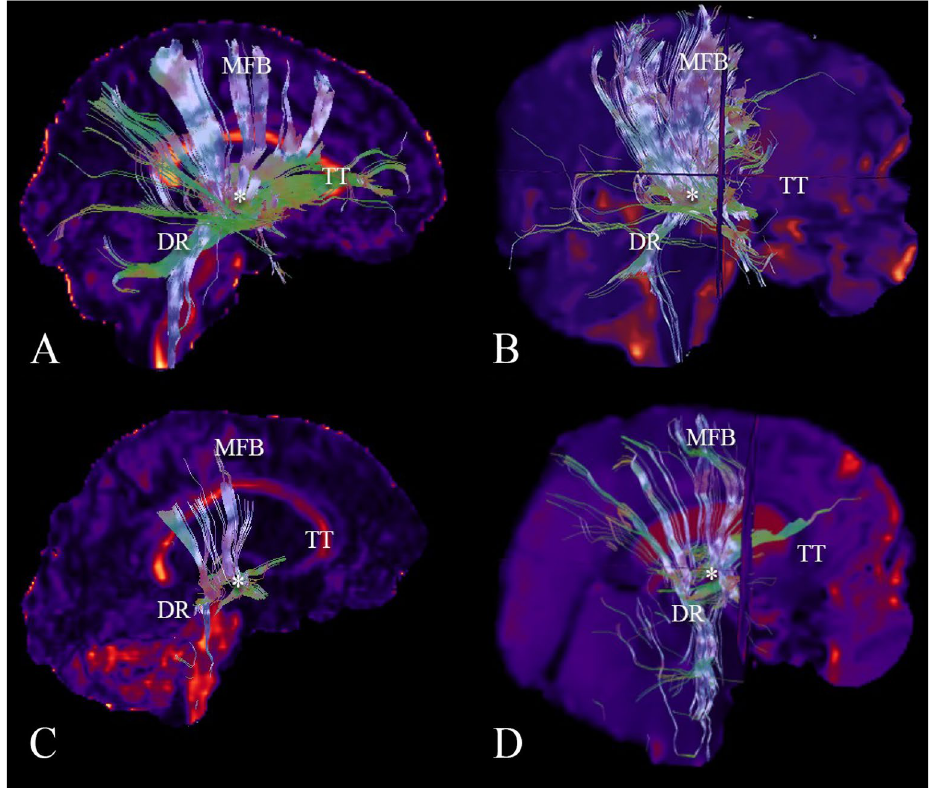
Figure 3. Reconstruction of the tractography of ascending arousal network. ( A ) A complete reconstruction of the AAN of a normal subject is demonstrated. Major components including the medial forebrain bundle (MFB) projecting to the dorsal frontal cortex, the dorsal raphe (DR), the thalamic-hypothalamic complex (asterisk), and superior and inferior tegmental tracts (TT) projecting to the basal frontal cortex are shown. ( B ) A reconstruction of the AAN of a comatose patient after a severe traumatic brain injury is observed, denoting a destruction of the tegmental tracts. ( C ) A reconstruction of the AAN of a patient after a stroke demonstrates a disruption of the tracts in the length of the MFB, the fibers of the DR, and the tegmental tracts. ( D ) A reconstruction of the AAN is shown in a comatose patient after a cardiac arrest, demonstrating a decrease in the number of fibers of all components of the AAN.